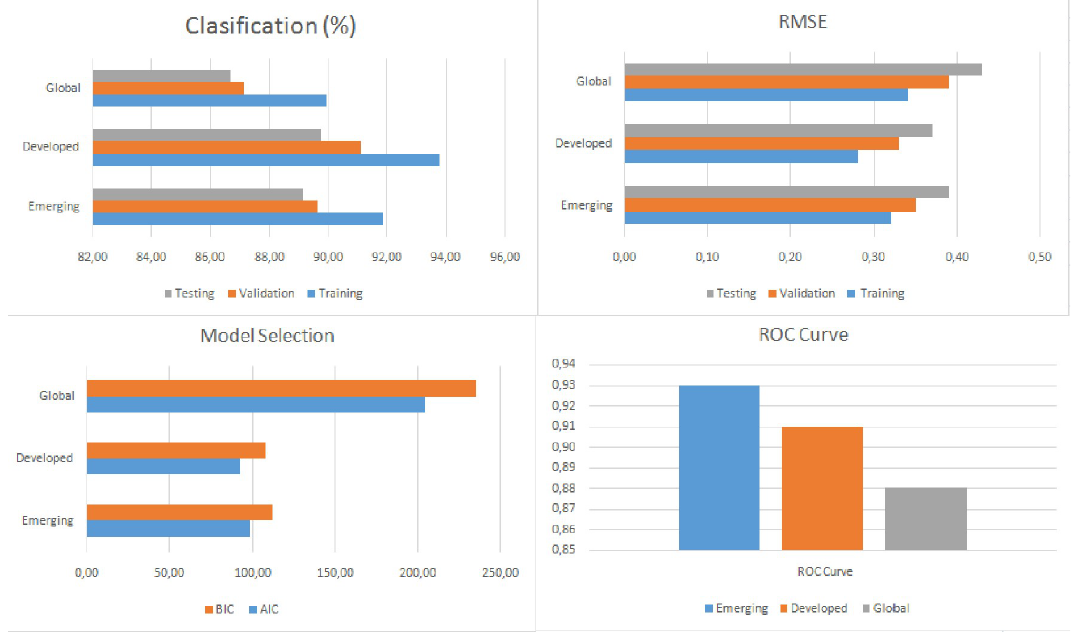
Fig 6. Results of accuracy evaluation for SS2.